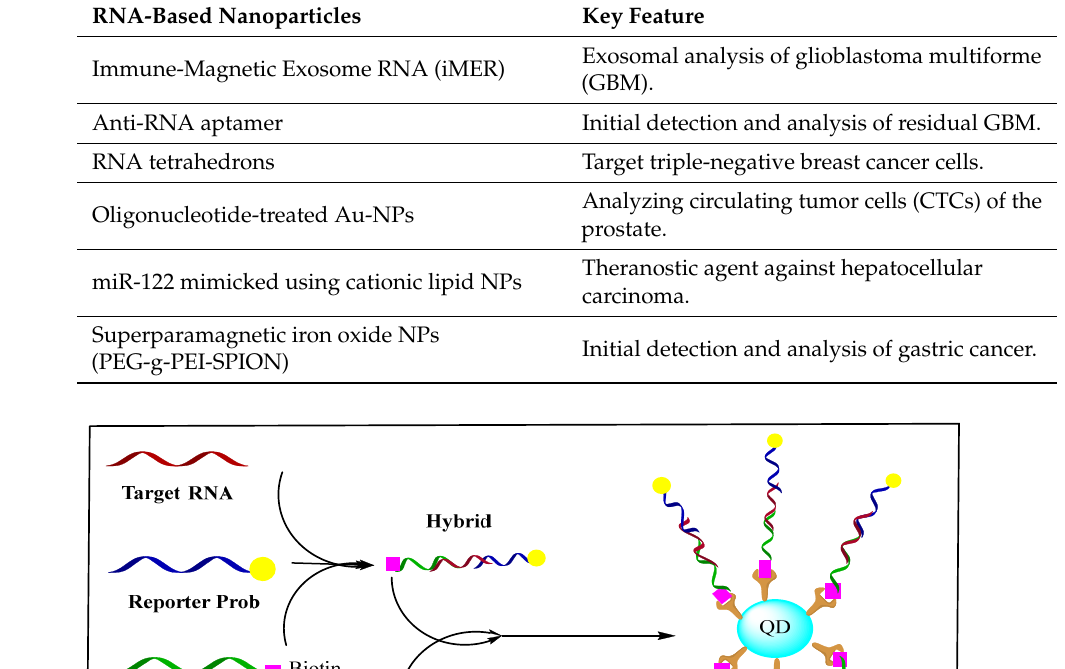
Table 1. Summary of RNA-based nanostructures in diagnosis of cancers. RNA-Based Nanoparticles